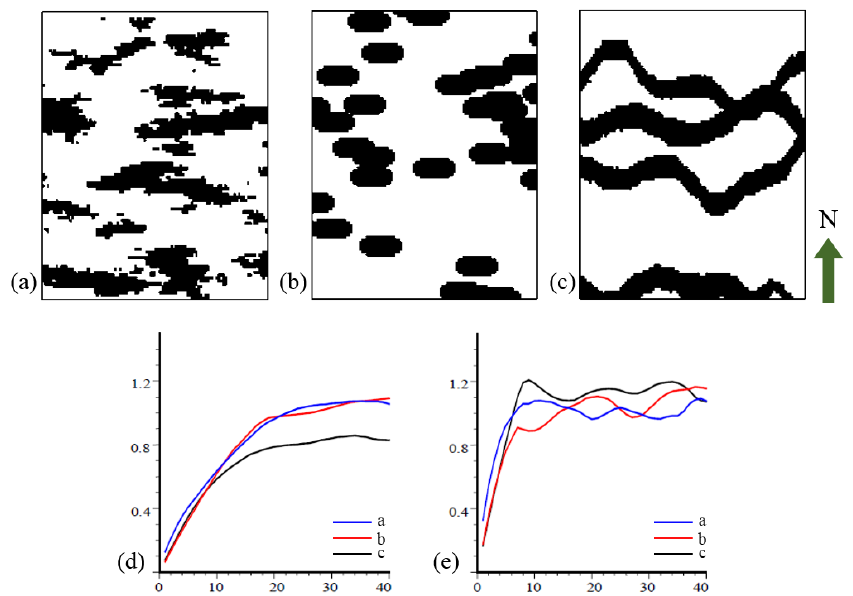
Figure 1. Variogram of two-point geostatistics is hard to characterize sufficiently the geological heterogeneity (modify according to reference [11]). ( a – c ) Three different geological heterogeneities; ( d ) Variograms in east–west; ( e ) Variograms in north–south.